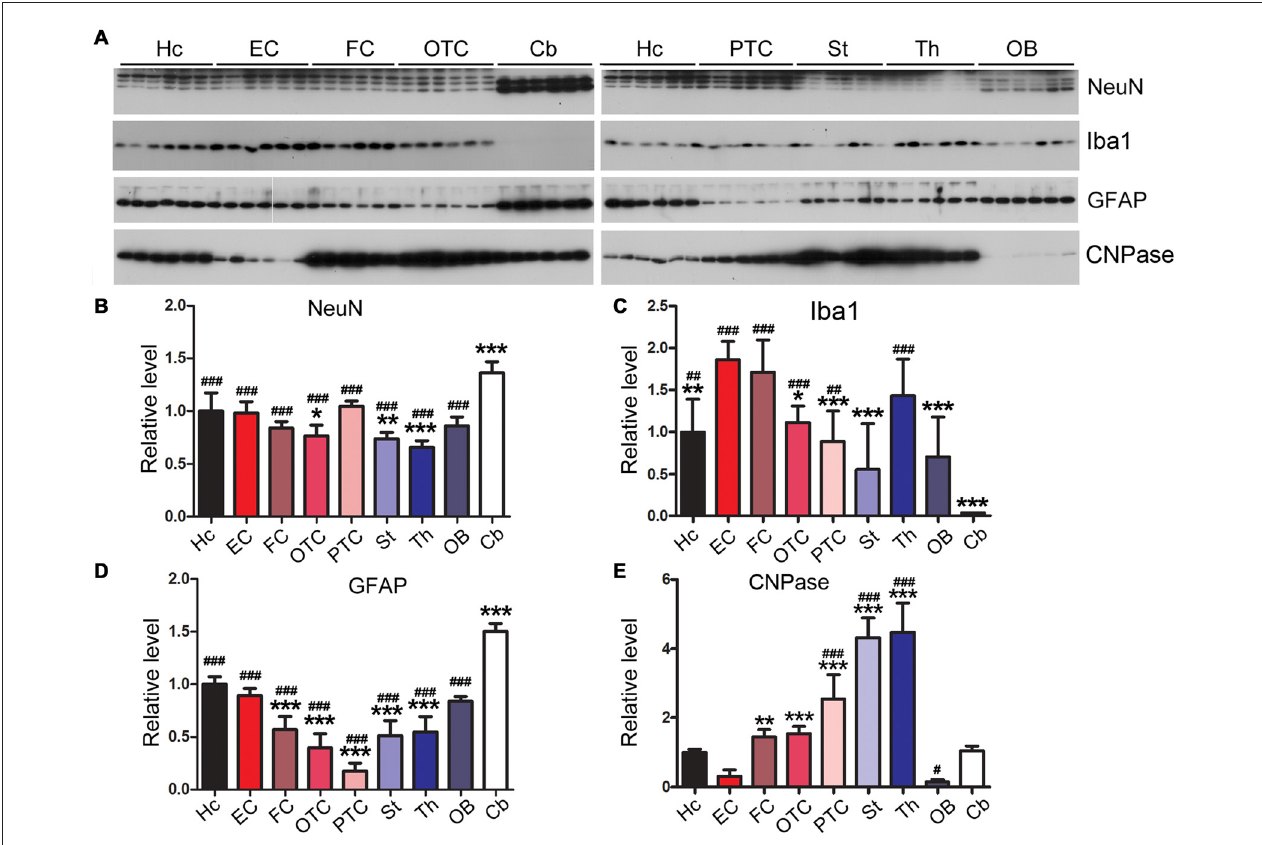
FIGURE 9 | Variable expressions of markers of glia and neurons in different regions of the rat brain. Western blots (A) were used to determine the expression levels of neuronal marker NeuN (B) and glial markers Iba1 (microglia) (C) , glial fibrillary acidic protein (GFAP; astrocytes) (D) and CNPase (oligodendrocyte) (E) in different rat brain regions. Data are expressed as mean ± SD, which represents matched observations of individual brain regions in six rats. ∗ Compared to EC; # compared to cerebellum. ∗ , # P < 0.05; ∗∗ , ## P < 0.01; ∗∗∗ , ### P <